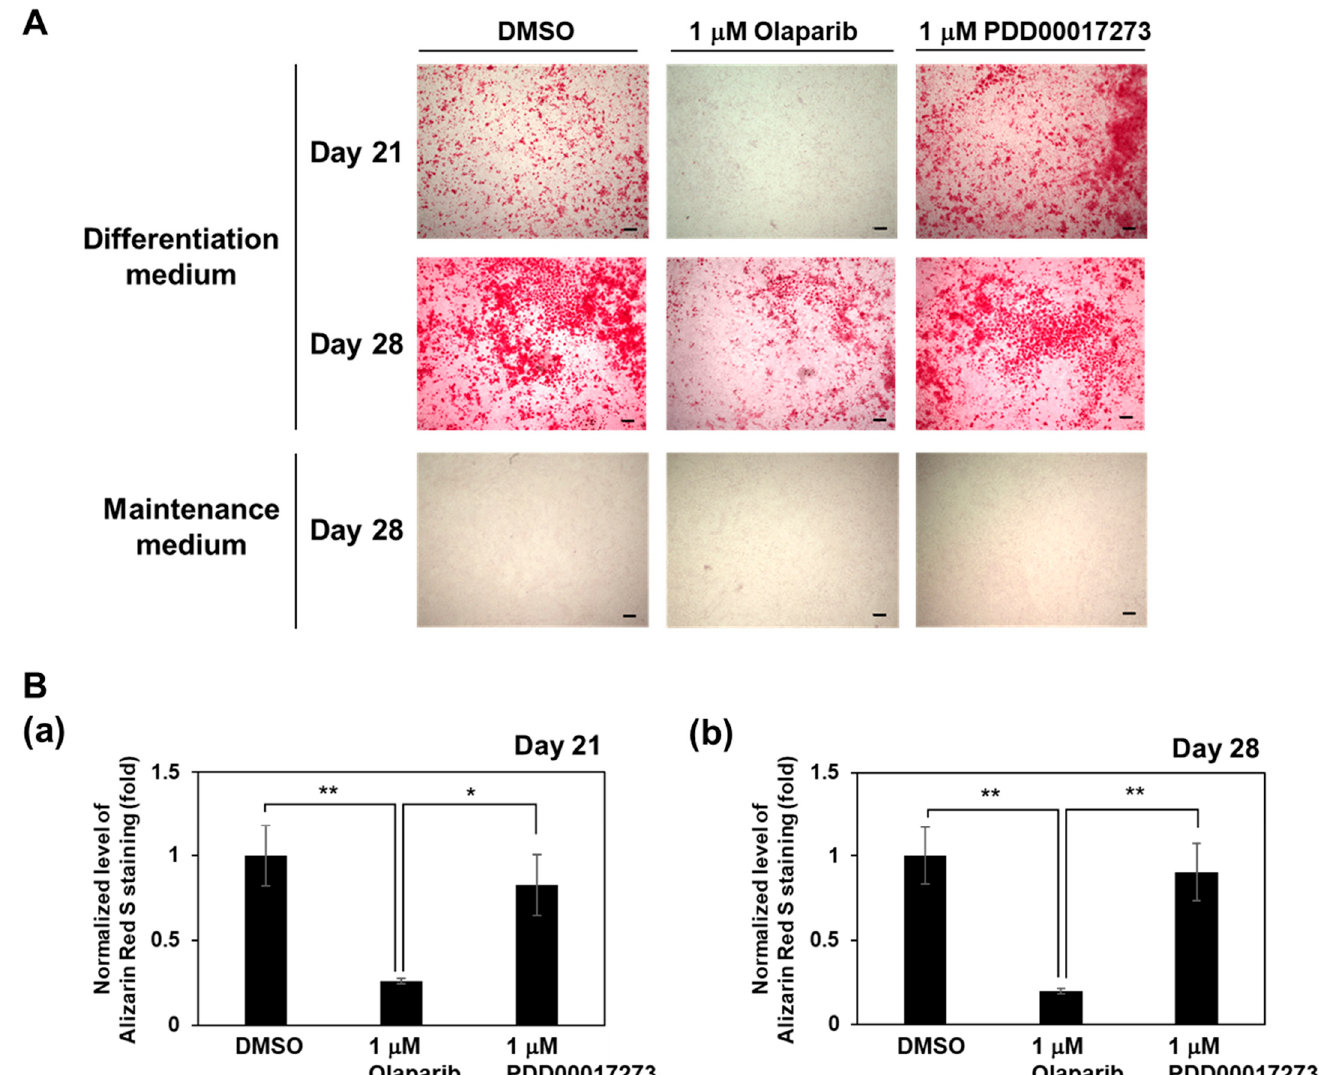
Figure 3. Effects of olaparib and PDD00017273 on matrix mineralization in MC3T3-E1 cells. MC3T3-E1 cells were cultured in differentiation medium in the presence of DMSO, 1 µM olaparib, or 1 µM PDD00017273 for 21 and 28 days after incubation of differentiation medium or maintenance medium. ( A ) Mineralized nodules were detected by Alizarin Red S staining. Scale bars indicate 200 µm. ( B ) Alizarin Red S staining level was quantified by measuring the absorbance at 415 nm. Graph showed quantification data of matrix mineralization at 21 days ( a ) and 28 days ( b ) after incubation in differentiation medium. In groups cultured in maintenance medium for 28 days, the absorbance at 415 nm was less than 0.1. Data are shown as mean ± SE. * p < 0.05, ** p < 0.01 (Tukey’s test).